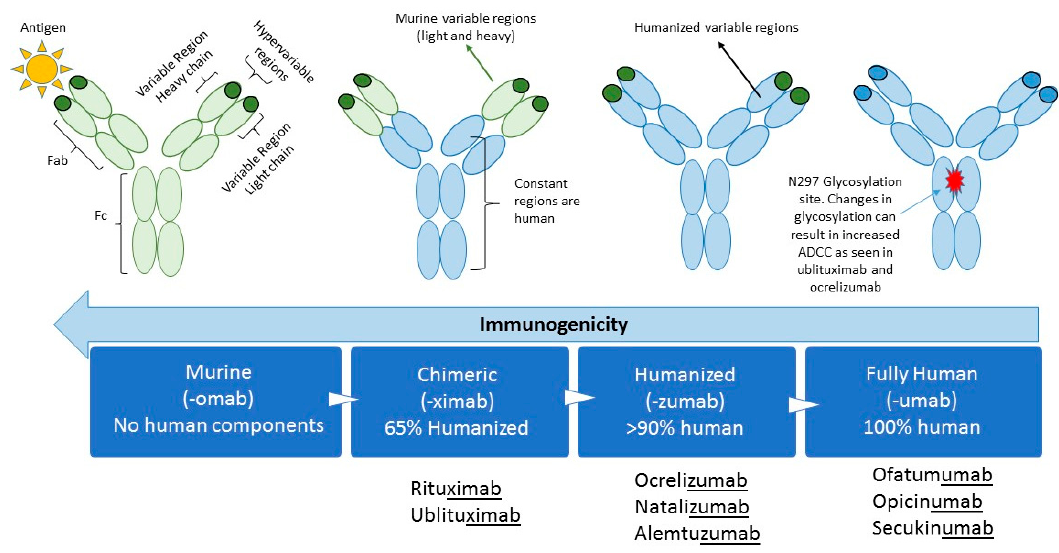
Figure 1. Bioengineering techniques have resulted in progressively more humanized antibodies. The figure shows the different fractions of the monoclonal antibodies and whether they represent mouse (green) or human (blue) sequences. As the sequences become more humanized their immunogenicity decreases. Glycosylation occurs at amino acid N297 and affects ADCC. Fragment antigen binding (Fab), Fragment crystallizable (Fc), Antigen-dependent cellular cytotoxicity (ADCC).